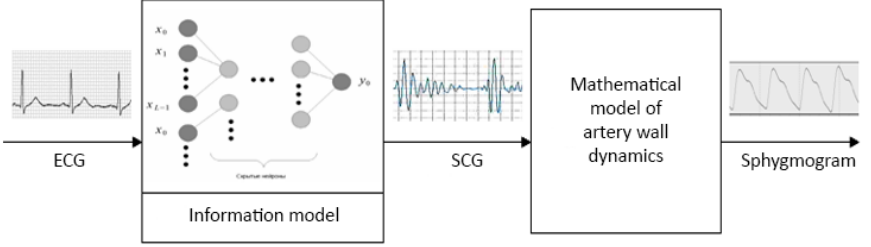
Fig. 6. Cardiovascular system